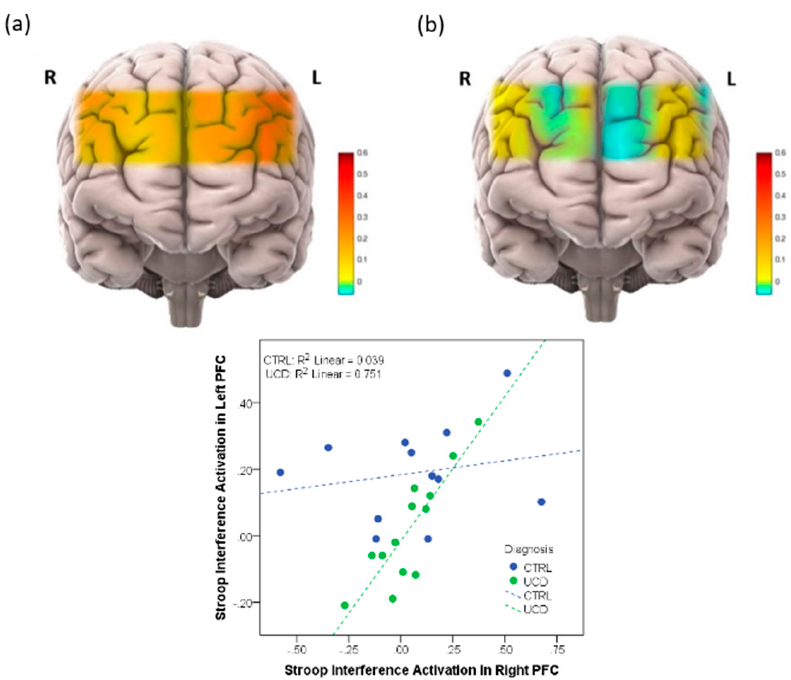
Figure 2. ( Top ): ( a ) Activation map in prefrontal cortex (PFC) in healthy volunteers, ( b ) Activation map in prefrontal cortex in patients with UCD. ( Bottom ): Correlation between right and left PFC in subjects with and without UCD.